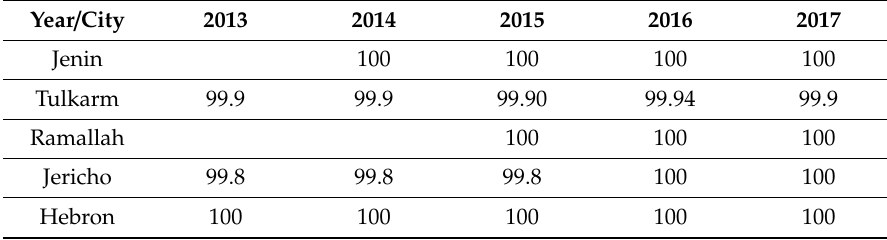
Table 6. Water resources availability (WRA)